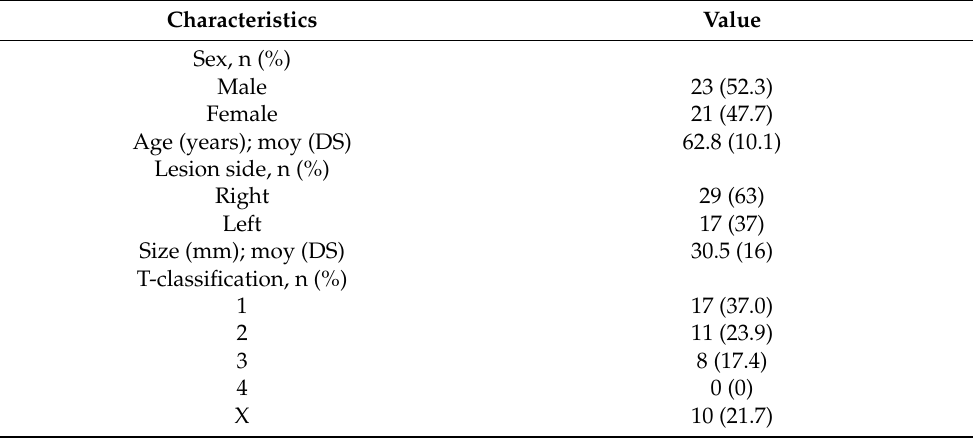
Table 1. Clinical and histological characteristics of the